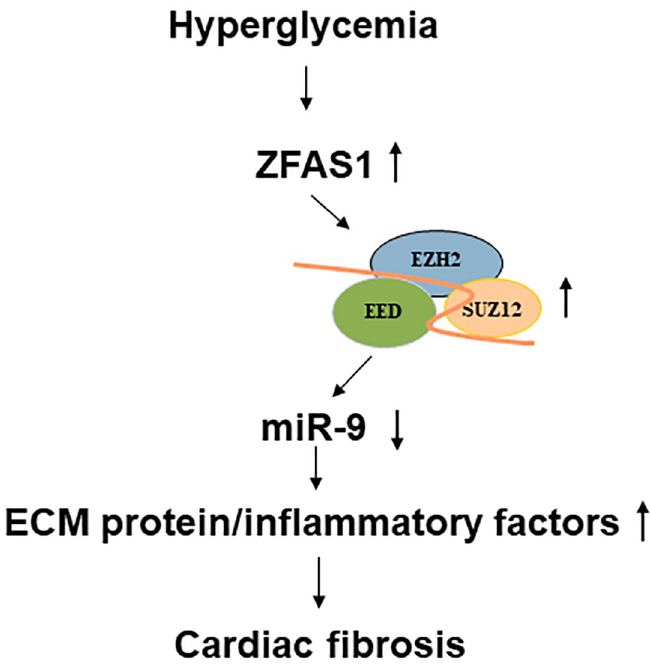
Fig 5. A schematic outline of the mechanism related to ZFAS1 in cardiac fibrosis in DCM.